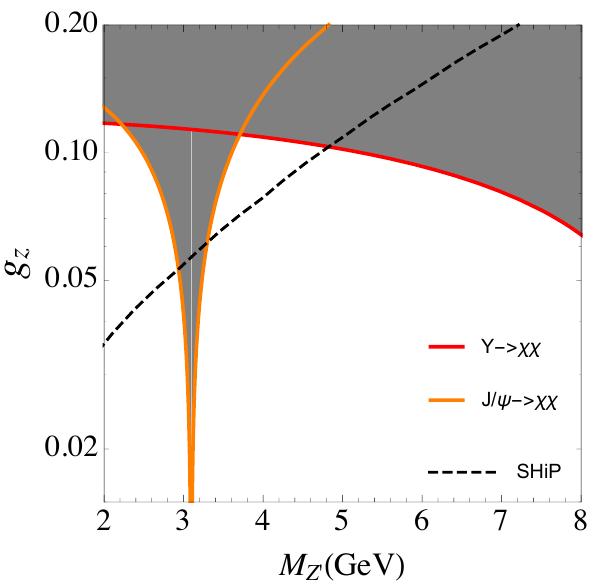
Figure 8. Sensitivity plot to a GeV leptophobic force at a SHiP like experiment obtained with MadDump assuming 9 (cid:2) 10 5 neutrino deep inelastic background events [7]. The DM mass has been (cid:12)xed to 750